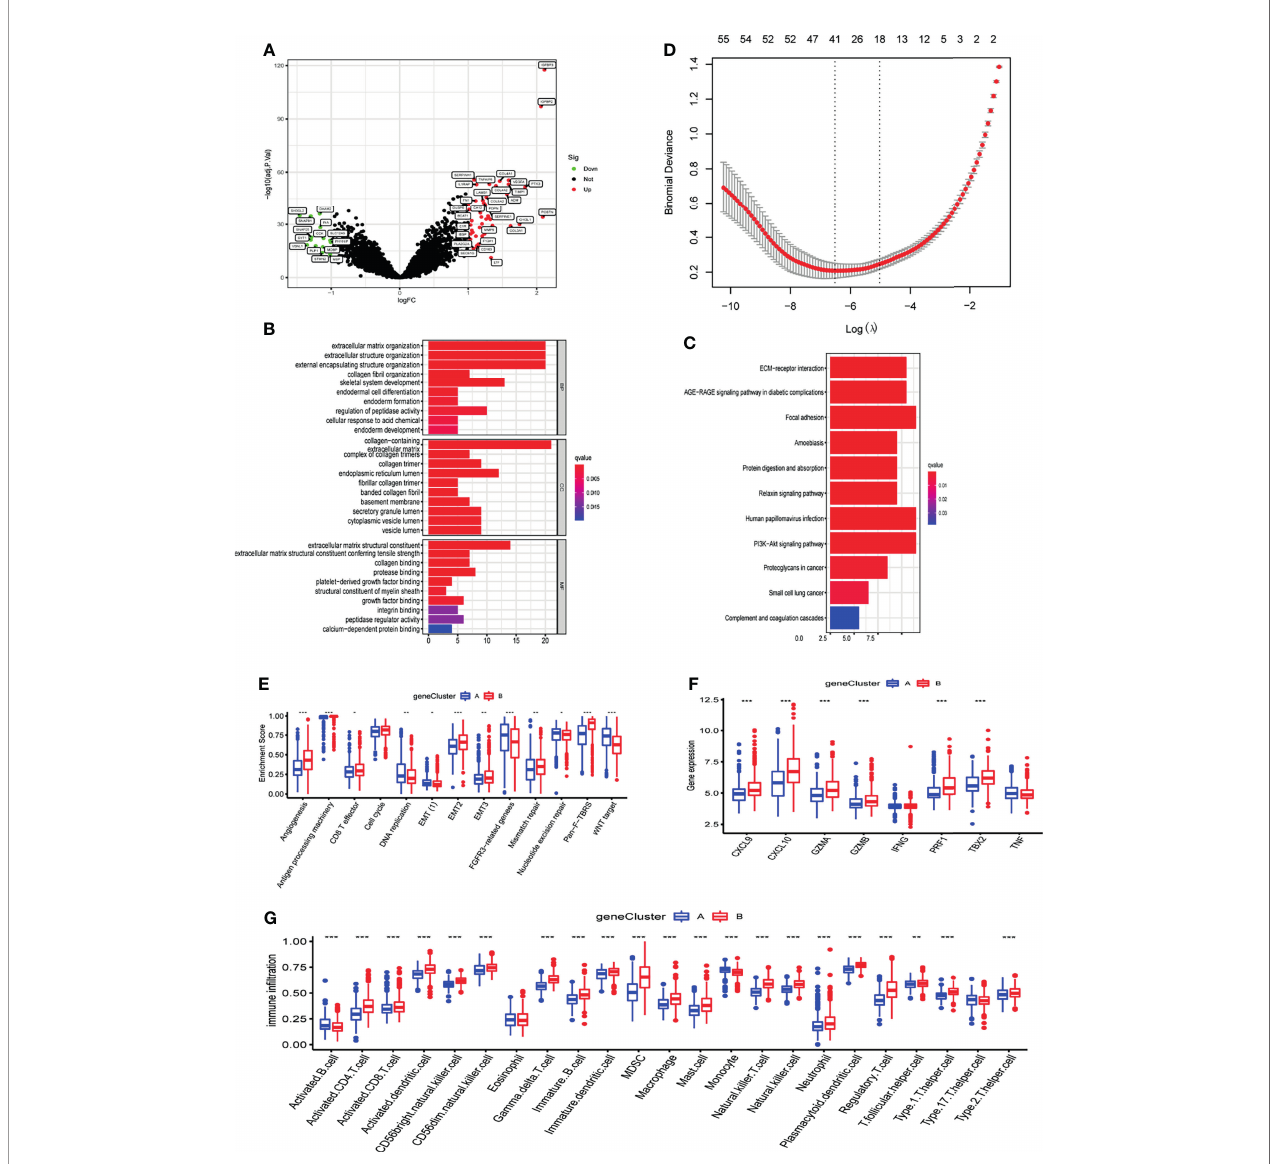
FIGURE 4 | Characteristics of m6A related phenotypes. (A) DEGs associated with the m6A phenotype. (B) GO enrichment analysis of differential genes (DEGs). (C) KEGG enrichment analysis of differential genes (DEGs). (D) Lasso analysis was used to obtain 41 signature genes of m6A methylation pattern. (E) The expression of common signatures in 2 m6A gene-clusters. (F) The expression of common immune activation genes in the 2 gene-clusters. (G) Abundance of Immune cell abundance in the 2 gene-clusters. *, **, and *** indicate p = < 0.05, < 0.01, and < 0.001,